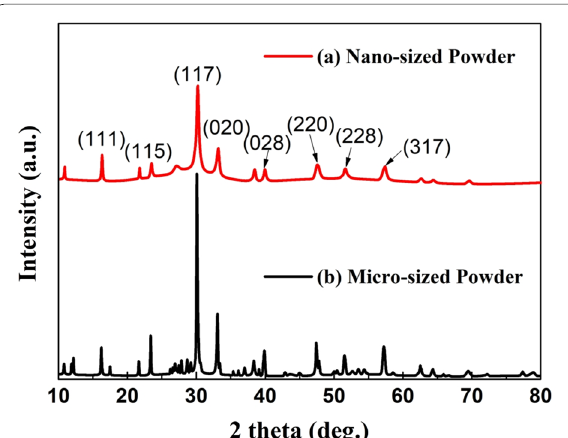
Fig. 5 Fourier-transform infrared (FT-IR) spectrometer of prepared pure PVDF